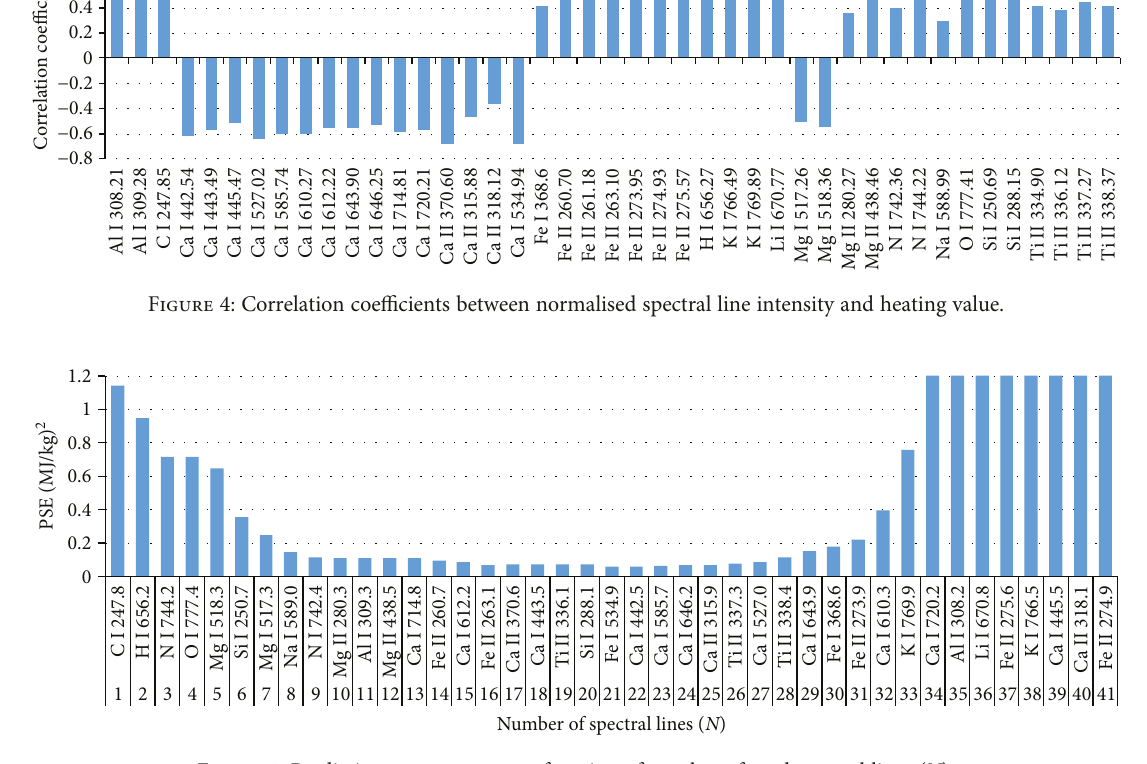
Figure 5: Predictive square error as a function of number of used spectral lines ( N